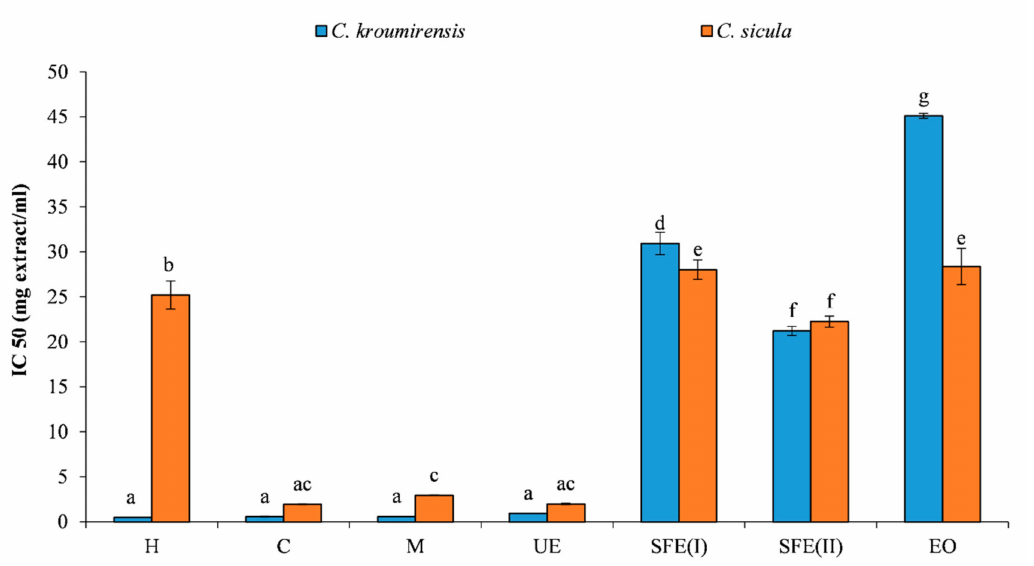
Figure 2. DPPH radical scavenging activity (IC 50 , mg / mL) determined in extracts obtained from aerial part of two Centaurea species ( C. kroumerienis and C. sicula ) with di ff erent extraction techniques (Di ff erent letters indicate significant di ff erence ( p <